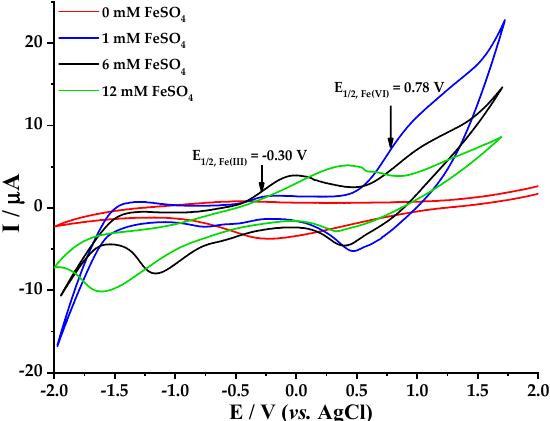
Figure 4. Voltammetric response of FeSO 4 at di ff erent concentrations, 0.05 M Na 2 SO 4 , on BDD 0.5 cm 2 as working electrode, scan rate 50 mV s − 1 ; counter electrode—platinum wire.